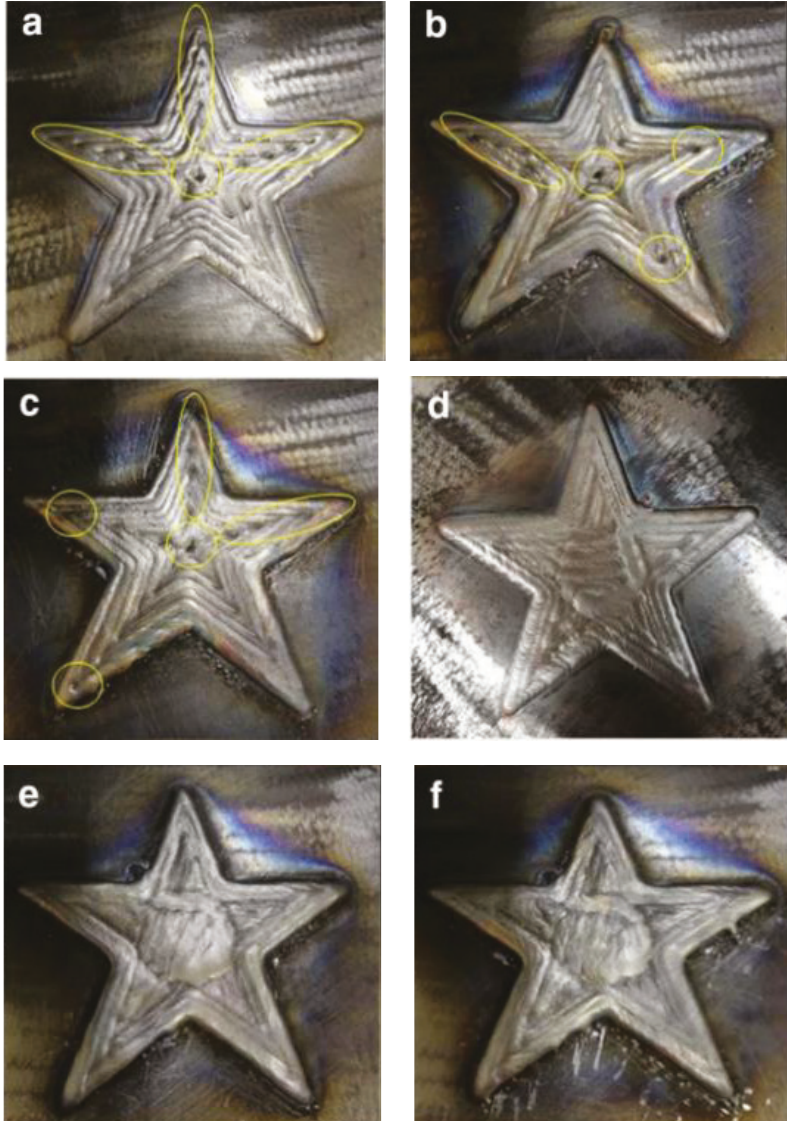
Figure 21: Experimental comparison of layers produced by proposed composite path filling strategy and contour offset path filling strategy: (a), (b), and (c) are the first, third, and fifth layers, respectively, produced using the composite strategy; (d), (e), and (f) are the first, third, and fifth layers, respectively, produced using the contour offset